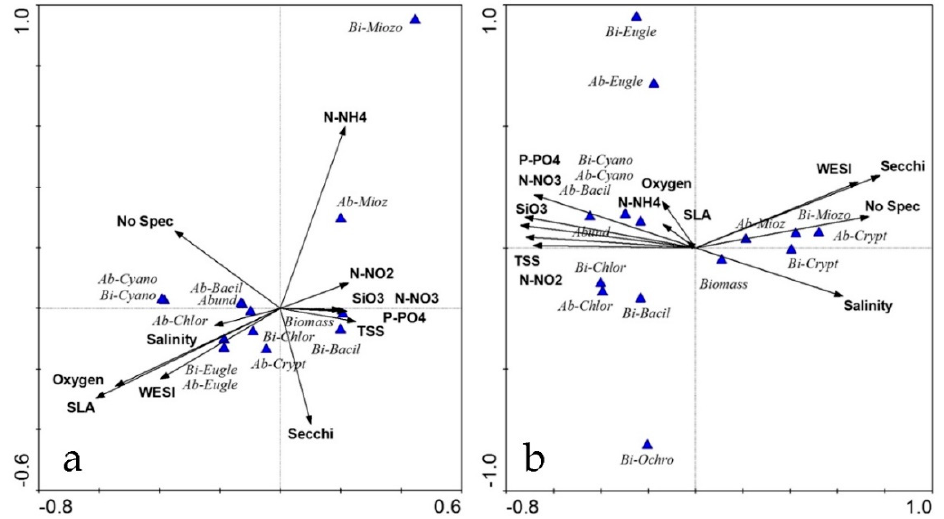
Figure 9. Ordination diagram based on the canonical correspondence analysis (CCA) analysis of species abundance and biomass on the surface ( a ) and bottom ( b ) horizon. Significance of the effect of six environmental variables: salinity, oxygen, nitrites (N-NO 2 ), nitrates (N-NO 3 ), ammonium (N-NH 4 ), orthophosphate acid (P-PO 4 ), silicic acid (SiO 3 ), total suspended substance (TSS), transparency (Secchi), number of species (No Spec), SLA (index of saprobity), WESI which is verified by Monte Carlo permutation test, p < 0.0182 ( a ), p < 0.0146 ( b ). The length and direction of the arrows indicate the relative significance and direction of change in environmental variables. Blue triangles—algae taxa (Bi—biomass, Ab—abundance).